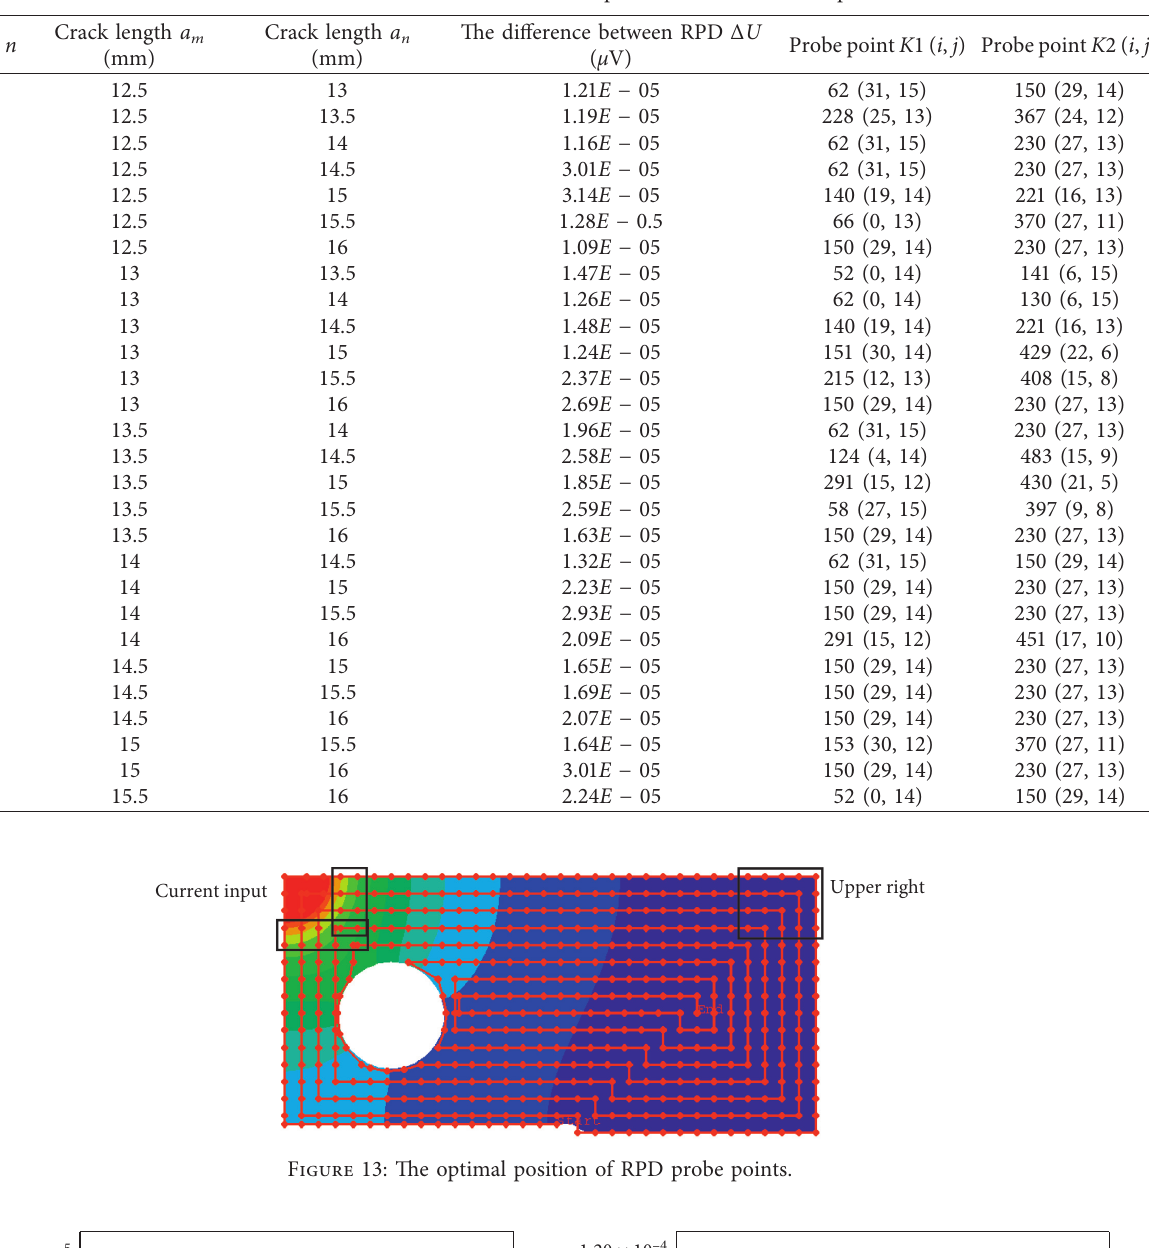
Table 4: The difference between the RPD after optimization of crack independence.